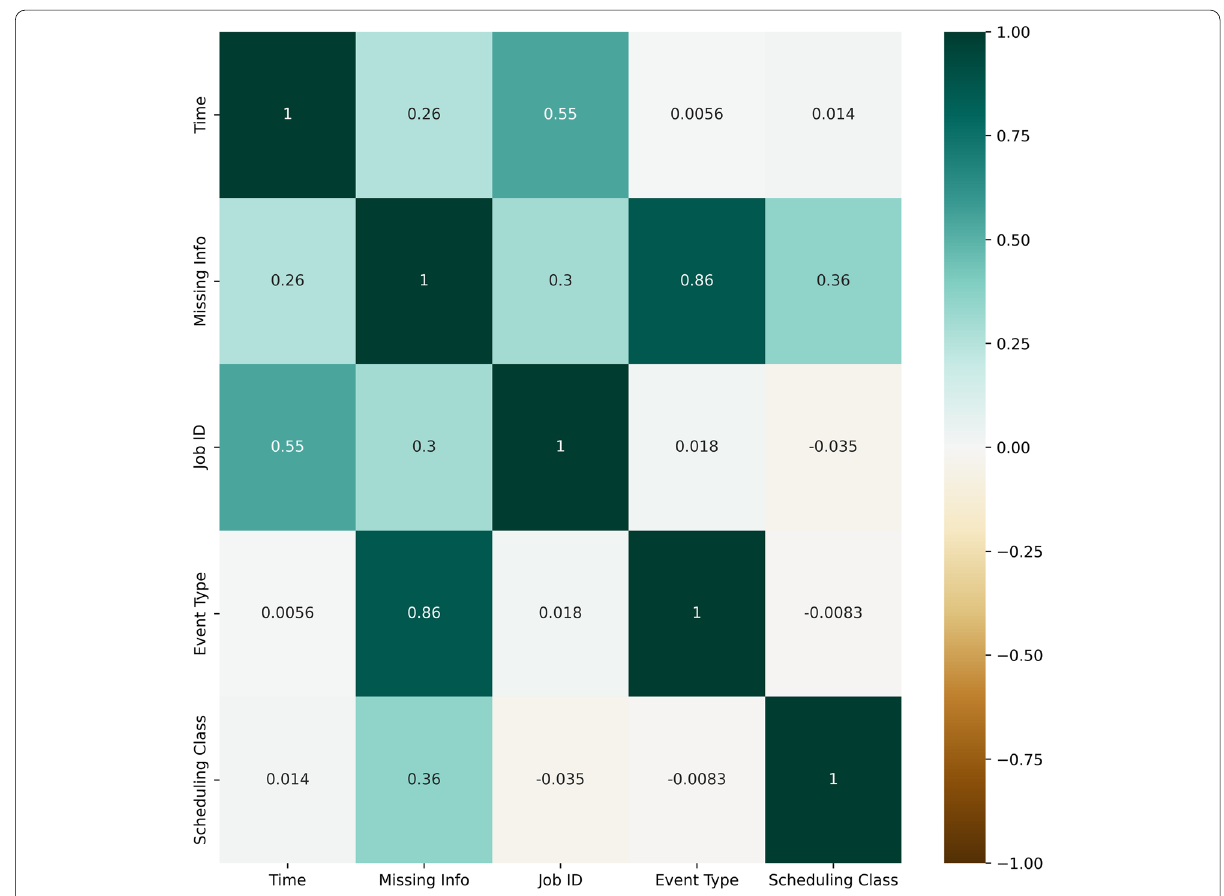
Fig. 5 Job Event Table Correlation. The figures shows the the heat map of the correlation analysis of the job event table